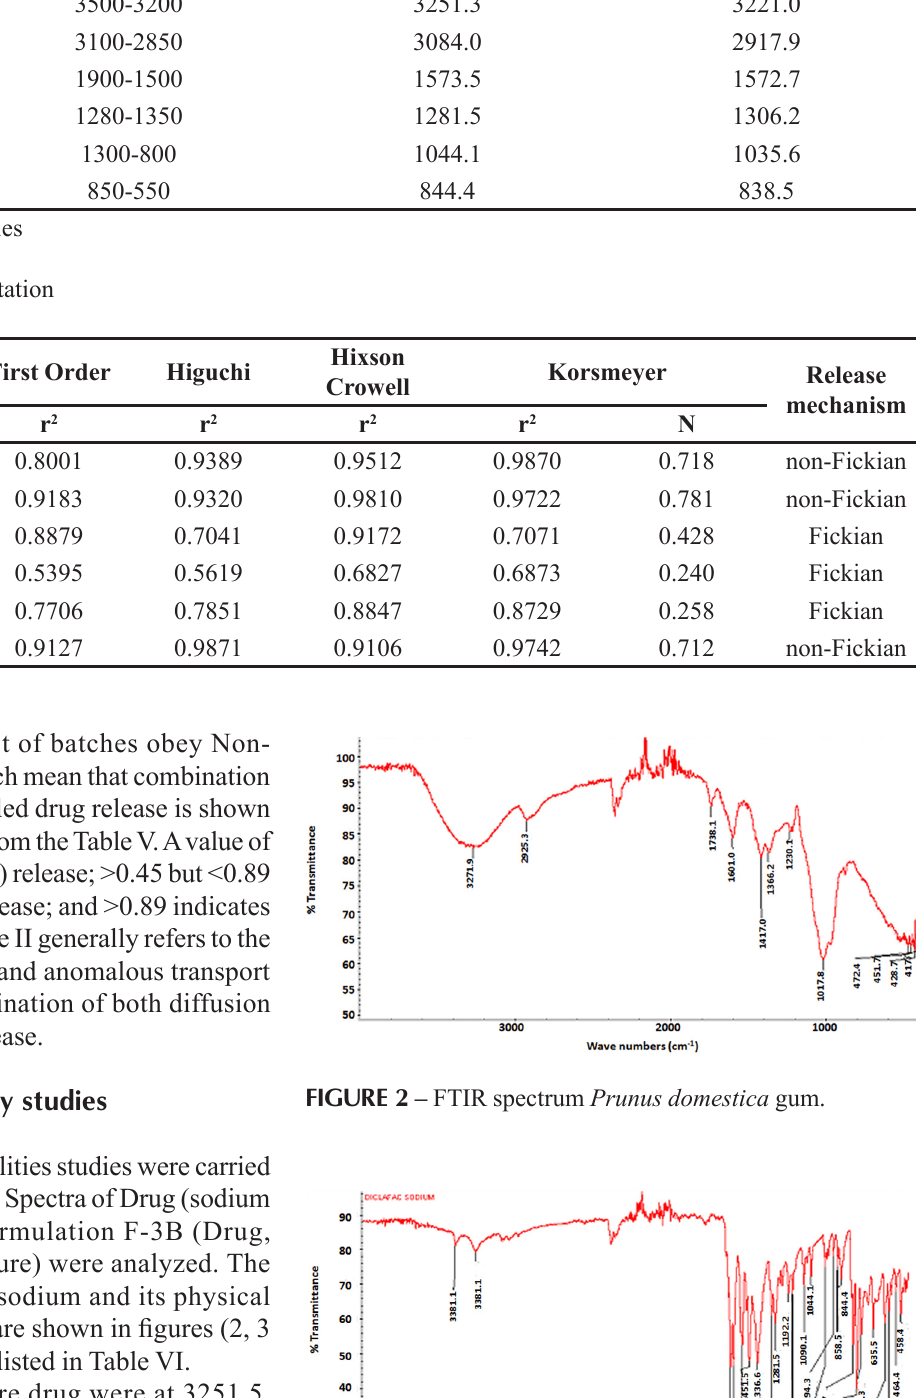
TABLE V – In vitro release kinetics of sodium diclofenac tablets Bonds/Group